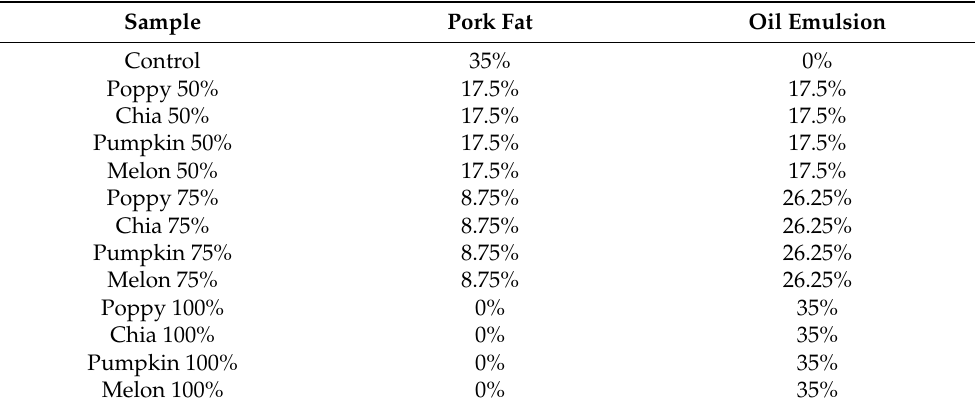
Table 1. Percentage of animal fat substitution used in each